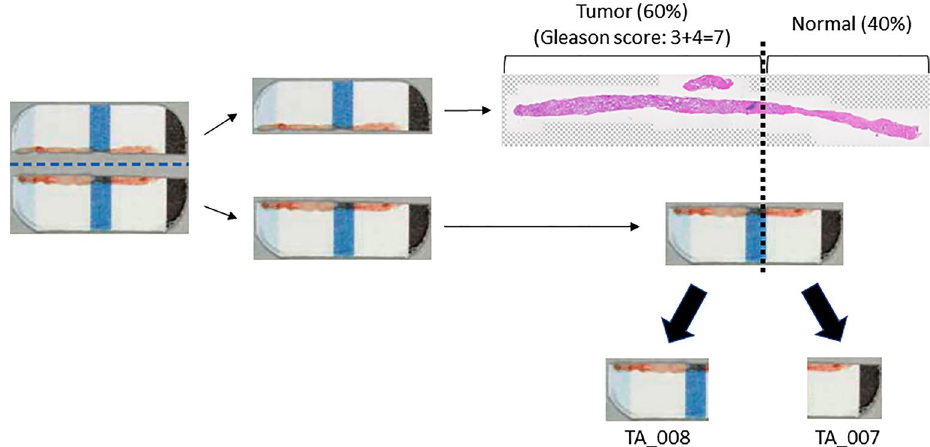
Figure 2. Representative images of trimming of a sample. To increase tumor cell content ratio, the divided sample is trimmed with reference to histopathological information.